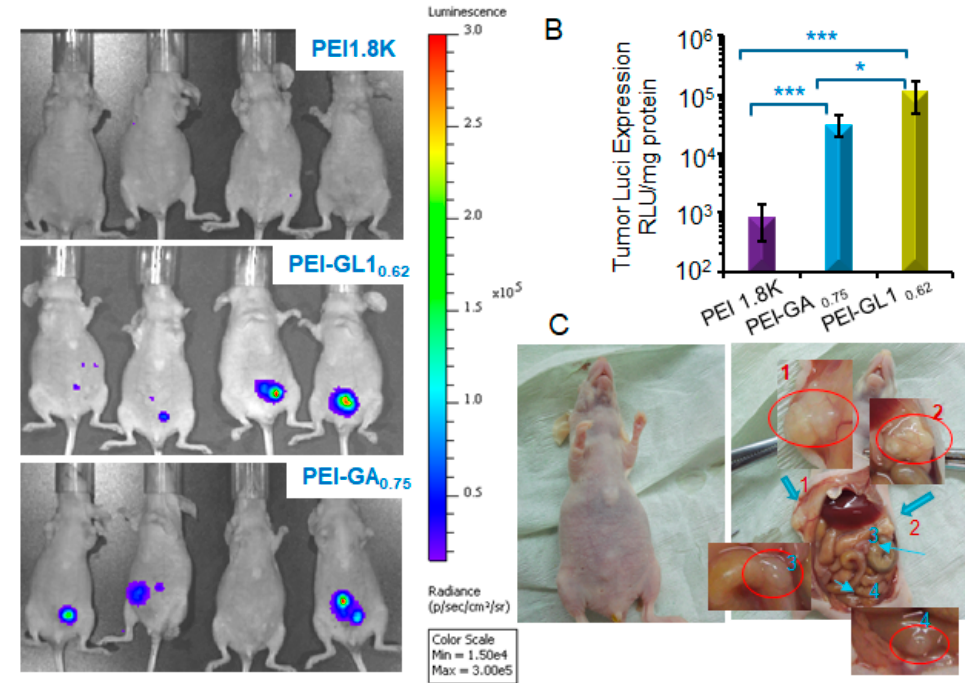
Figure 9. In vivo Luciferase expression e ffi ciency of the polyplexes and the PEI1.8K control. ( A ) Tumor bioluminescent image and ( B ) the corresponding chemiluminescence measurements of the dissected tumor tissues in the HepG2- intraperitoneal tumor nude mice model at 48 h post i.p injection of PEI / pLUCI, PEI-GA 0.75 / pLUCI and PEI-GL1 0.62 / pLUCI polyplexes. The luciferase plasmid dose was 0.5 mg · kg − 1 ; 48 h in vivo transfection, n = 4 mice in each group. Statistically significant di ff erences are indicated by * p < 0.05 and *** p < 0.001 using t -test. ( C ) Tumor nodules of representative mice. Arrows show tumors around the liver, and intestines, or in the intestines.